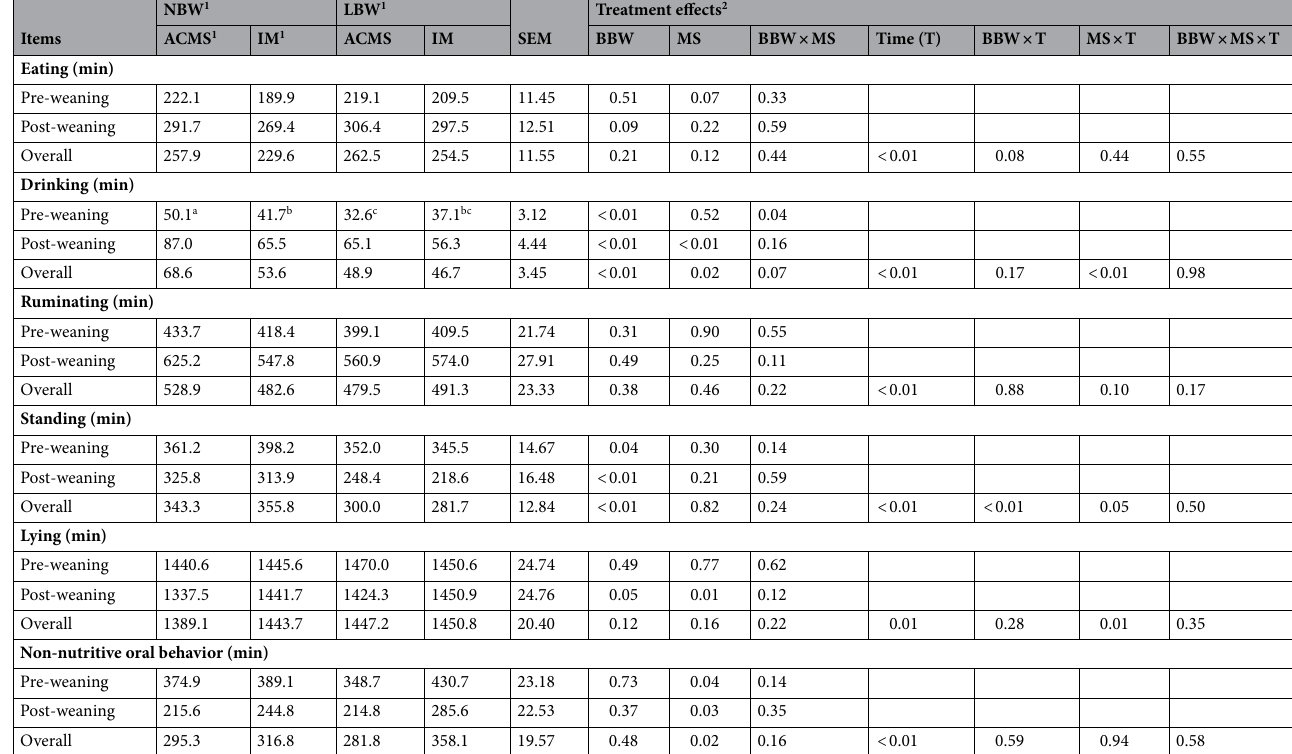
Table 7. Effects of dietary mineral source and birth body weight (BBW) on total time devoted to performing different behaviors (min) during 48 h of observation of dairy calves (n = 13 per treatment). 1 IM inorganic minerals source, ACMS advanced chelated mineral source, LBW low birth weight, NBW normal birth weight. 2 Contrasts for BBW (birth body weight), MS (mineral source) and interaction (BBW × MS). a,b,c Means